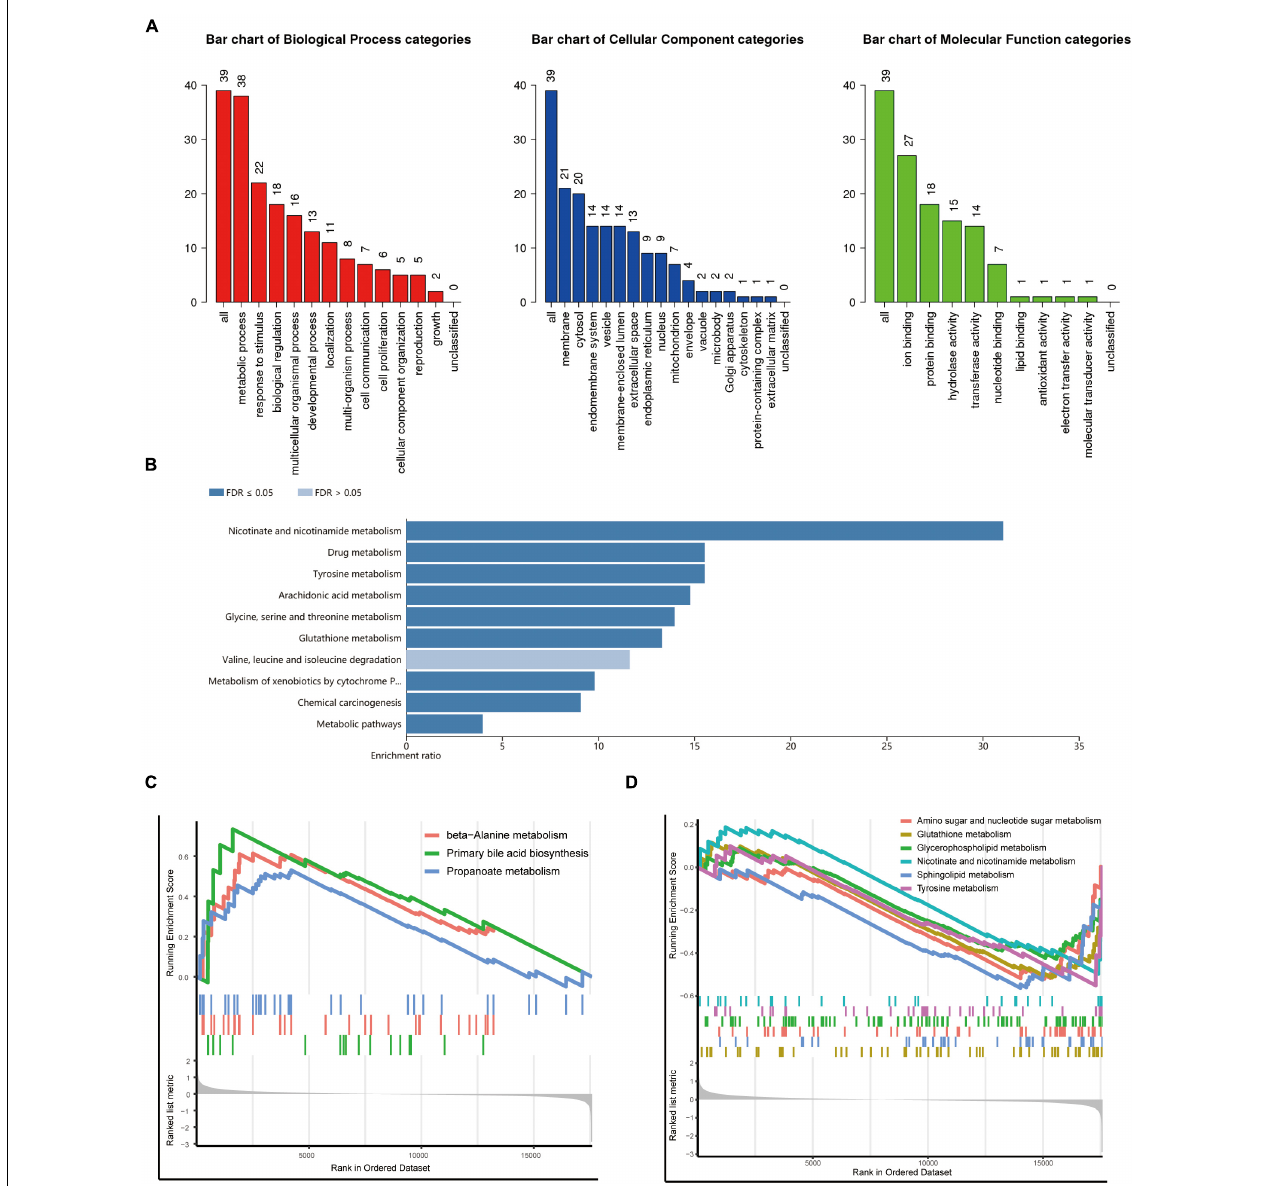
FIGURE 2 | Functional and pathway enrichment analysis. (A,B) Gene Ontology (GO) (A) and Kyoto Encyclopedia of Genes and Genomes (KEGG) (B) enrichment analysis of the metabolism-related genes. (C,D) Representative Gene Set Enrichment Analysis (GSEA) results of the upregulated (C) and downregulated (D) metabolism-related